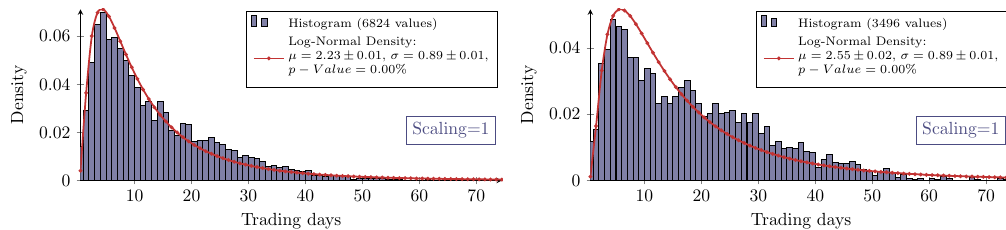
Figure 8. Measured and log-normal fit density of the retracement duration in up- and down-trends ( a and b respectively) with scaling one for S&P100 stocks. The data are visualized with a histogram with a bin size of